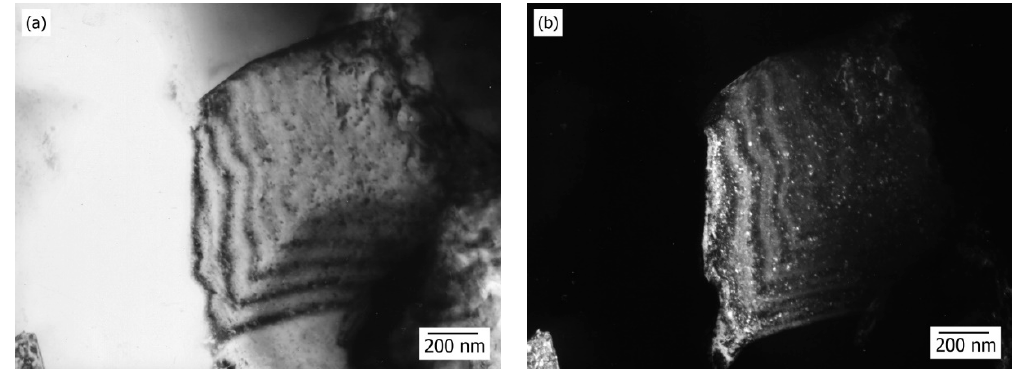
Figure 5. TEM analysis of a single copper grain containing a fine dispersion of alumina particles, dislocations and Moire fringes .